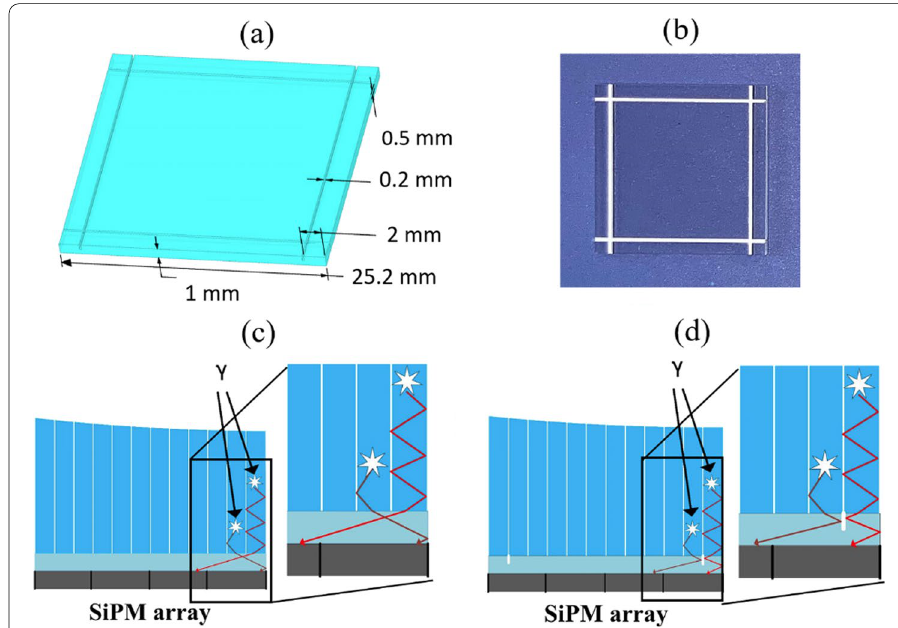
Fig. 2 a Mechanical design, b photo of the light guide with grooves, and c – d illustration of how photon transport in the edge crystals and light guide improves the identification of the edge